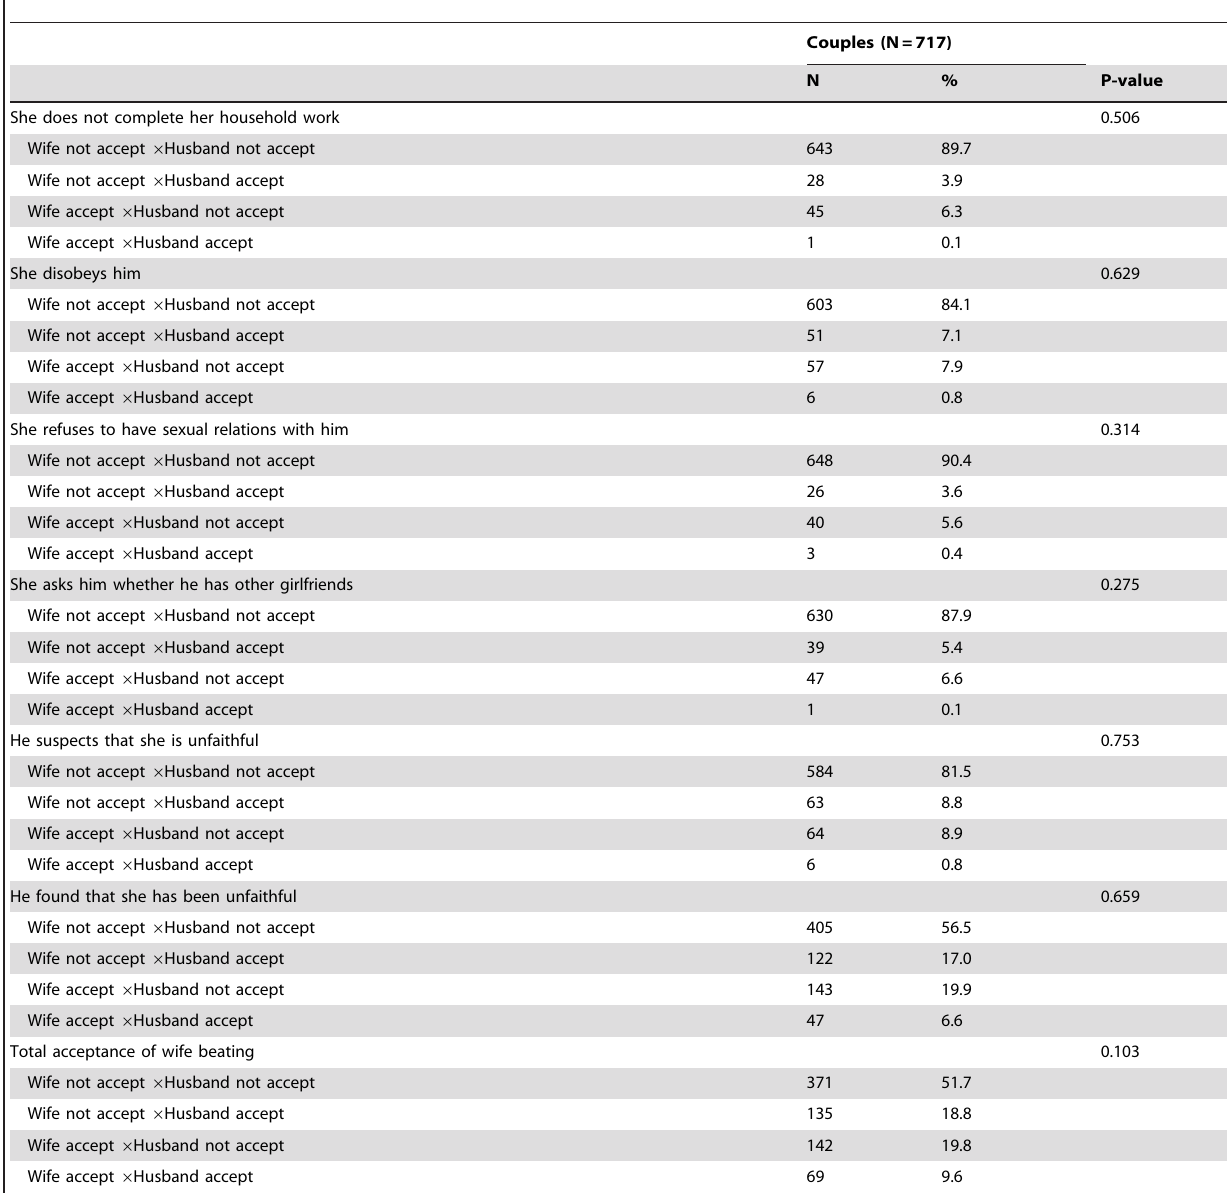
Table 2. Comparison of acceptance of wife beating among Nepalese